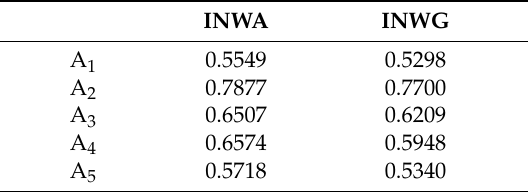
Table 5. The score functions of the emerging technology